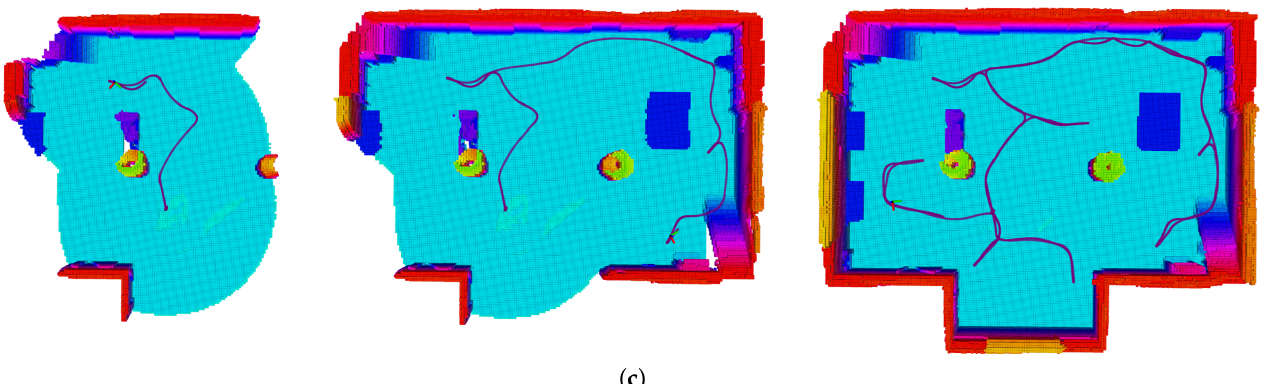
Figure 6. Exploration in indoor scenario, the three utility formations are compared, the color of the grid changes from blue to red as the height increases. ( a ) Exploartion using linear utility. ( b ) Exploar- tion using exponential utility. ( c ) Exploartion using normalized utility.